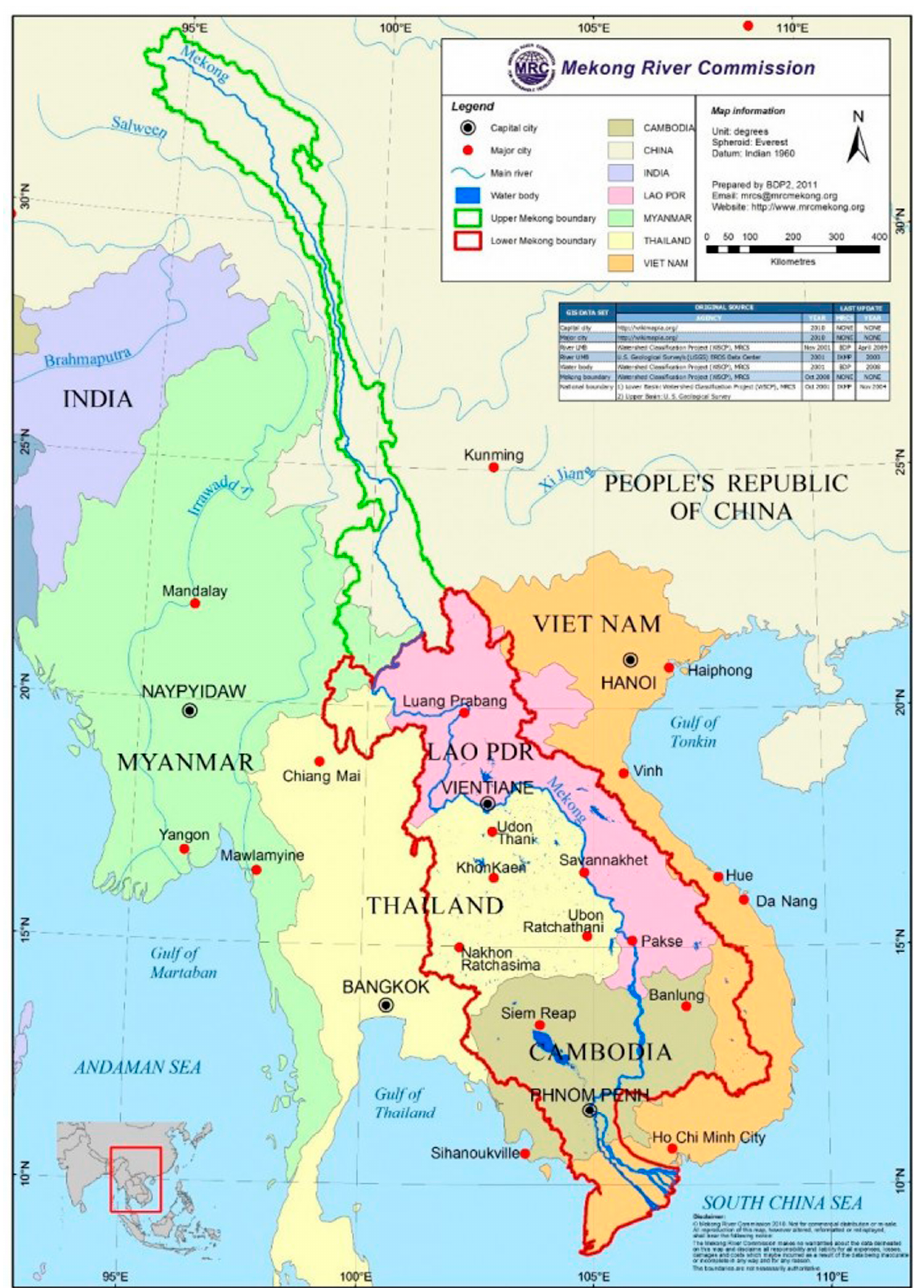
Figure 2. Geographical location of the Lancang–Mekong River Basin (LMRB)